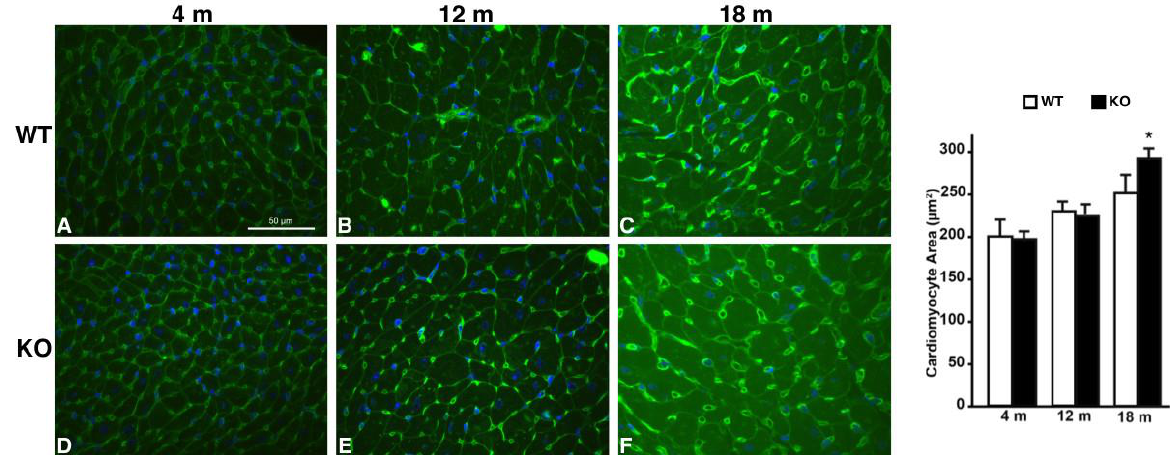
Figure 7. Effects of Hipk2 deletion in cardiomyocyte cell size. Left panel: representative images of WGA staining of heart sections from WT ( A – C ) and Hipk2 -KO ( D – F ) at 4, 12, and 18 months of age, respectively. Scale bar = 50 µ m. Right panel: quantification of cross-sectional area of cardiomyocytes from WT and Hipk2 -KO at 4, 12, and 18 months of age (* p < 0.05).